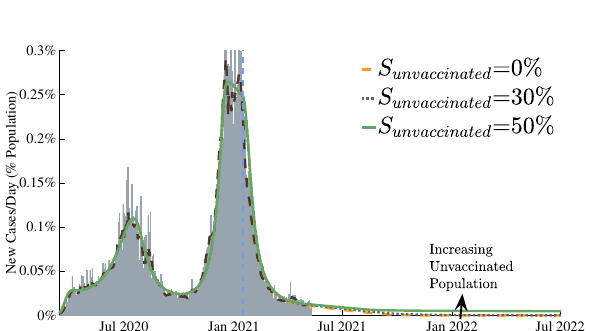
Figure 5. Contour plot of the sense of normalcy, d V , and vaccination rate, α , versus the total infections since the start of vaccination (red values shown as proportion of the total population). Shown for a high level of caution case ( d I = 500). The pink box shows a possibility of increasing number of total infected cases with increasing vaccination rate at very high sense of safety, and the teal box shows that once the vaccination rate crosses a threshold, the total number of infection cases drop with vaccination rate even at a very high sense of safety.